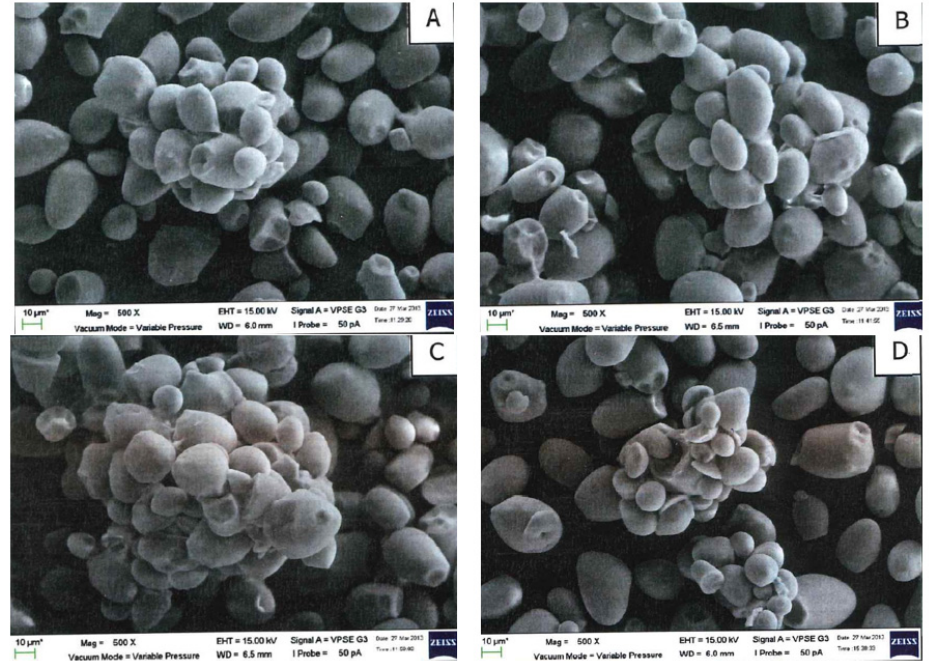
Figure 3. Scanning electron micrographs for ( A ) 5kGyANN(T o -5); ( B ) 10kGyANN(T o -5); ( C ) 25kGyANN(T o -5); ( D ) 50kGyANN(T o -5) (500× magnification).